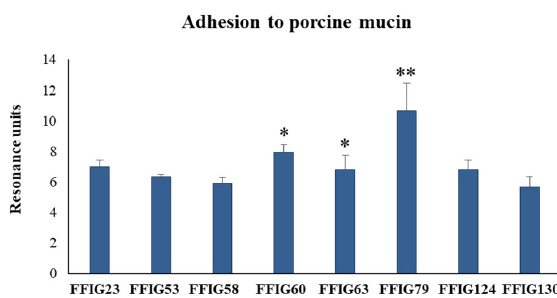
Figure 6. Adhesion of Ligilactobacillus salivarius strains isolated from the intestinal mucosa of wakame- fed pigs to porcine mucins. The results represent data from three independent experiments. Asterisks indicate significant differences when compared to the strain with the lowest adhesion ability (* p < 0.05, ** p < 0.01).